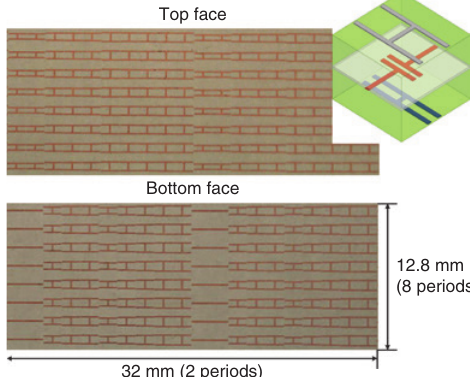
Figure 8: Translated G parameters of bianisotropic boundary condi- tions for 0 ° to 71.8 ° TE refraction at 20 GHz.